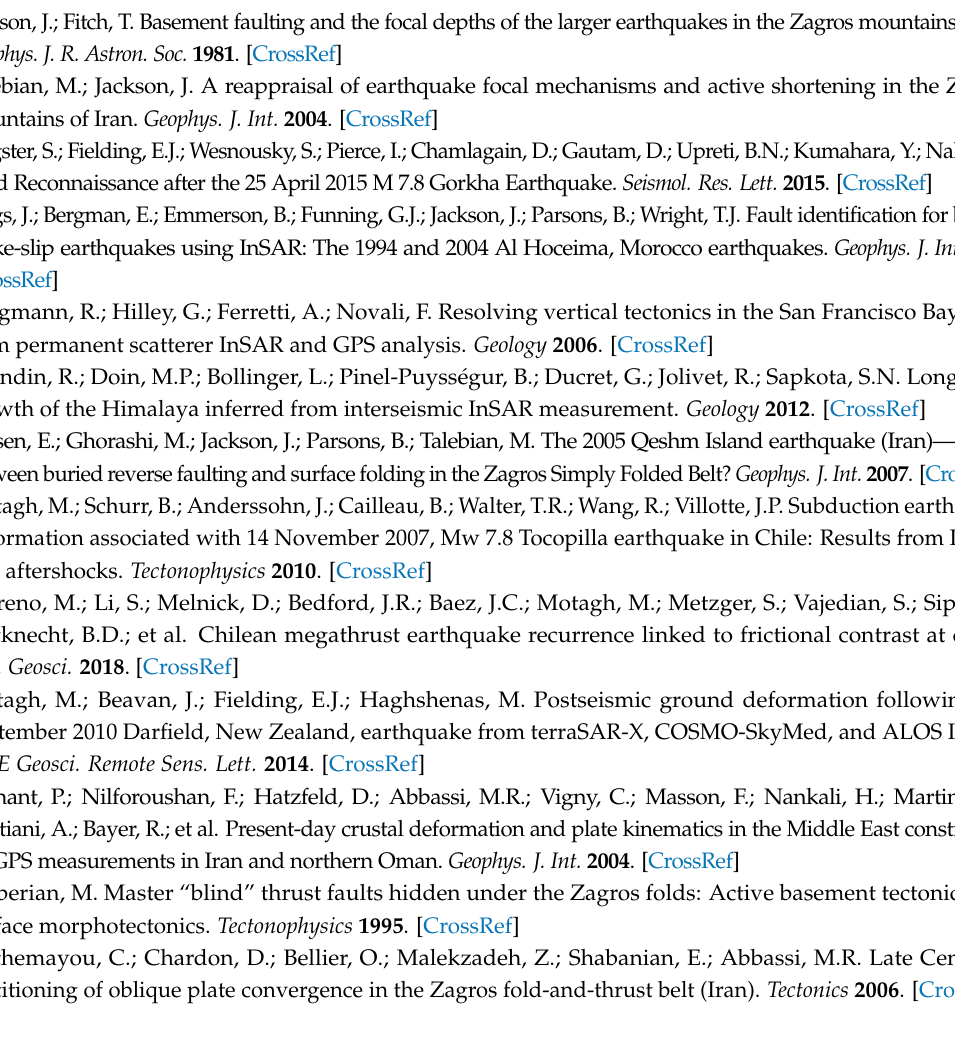
S1: Moment tensor solutions from various agencies; Table S2: Details of interferograms processed in this study; Table S3: Fault parameter intervals and best-fit solution from uniform slip inversion; Table S4. Fault plane solution suggested from geodetic and seismic data; Table S5. Uncertainty values calculated for across-track and